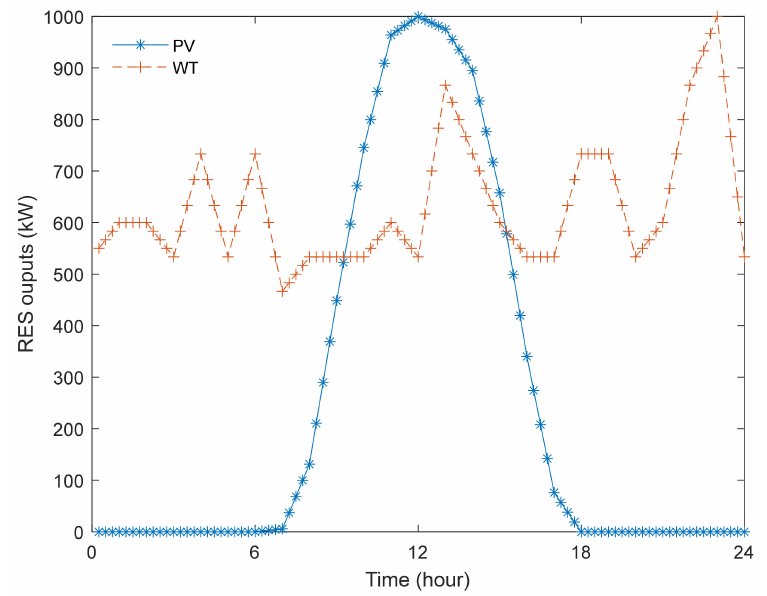
Figure 5. PV and WT total output